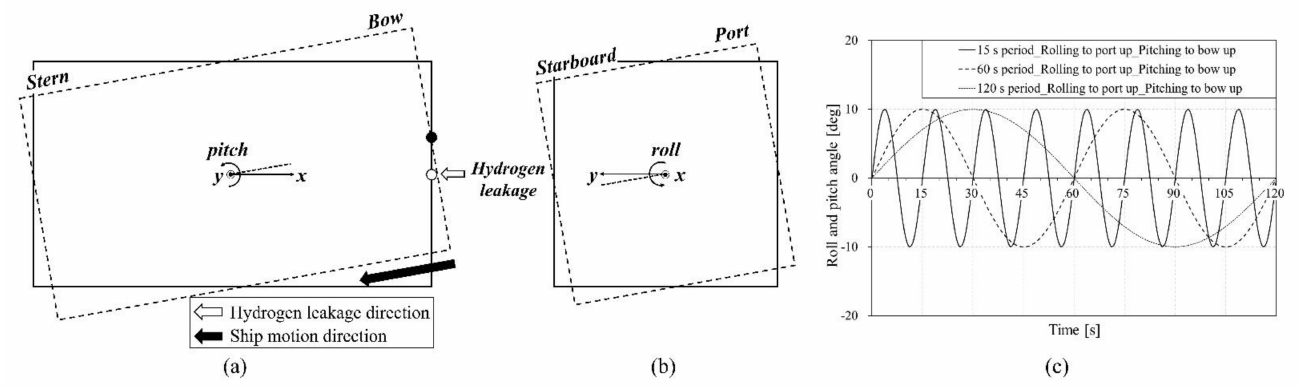
Figure 7. Plane view and ship motion period graph: ( a ) Pitching to bow up; ( b ) Rolling to port up; ( c )